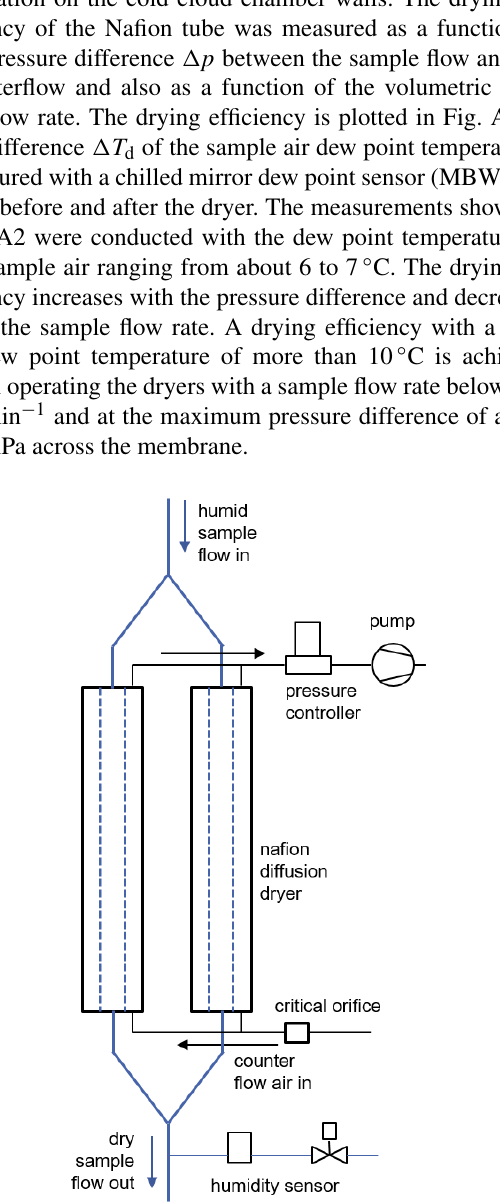
Figure A1. Schematic setup of the dual Nafion dryer as part of the PINE inlet system.